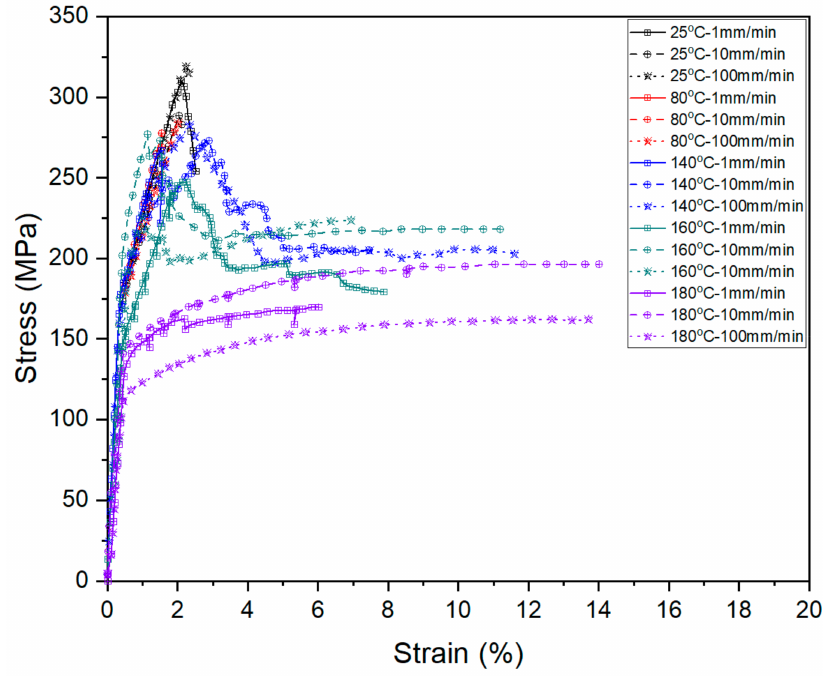
Figure 6. Tensile stress-strain curves under different temperatures and stretching